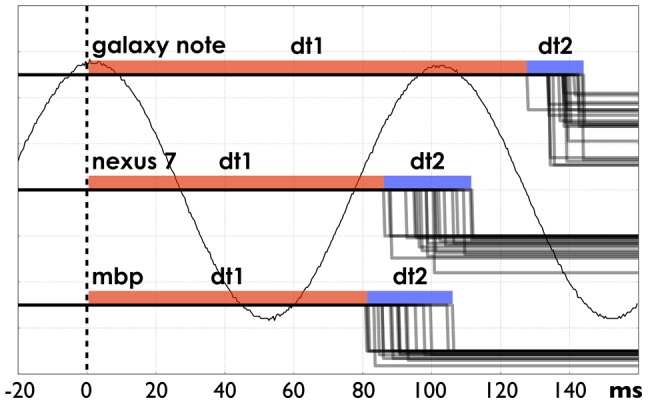
System response timings.The system responds to the sinusoid signal peak (time 0). The red color (dt1) indicates minimal observed delay; the blue color (dt2) indicates jitter. Galaxy Note running Android 4.0.1, 60 Hz AMOLED screen, dt1  =  125ms, dt2  =  16ms; Nexus 7 running Android 4.1.1, 60 Hz IPS LCD screen, dt1  =  85ms, dt2  =  26ms; MacbookPro, LCD screen (60 Hz), dt1  =  80ms, dt2  =  26ms.